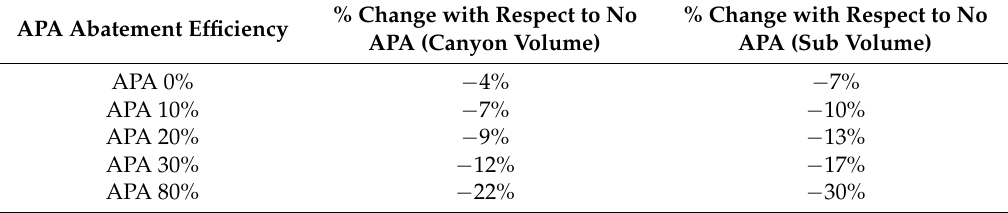
Table 2. Percent change of passive tracer average concentration in the entire volume of the canyon and in a sub-volume at human height with respect to the reference case without the scrubber for H/W = 2. Different APA abatement efficiencies are analyzed. Simulated values are relative to concentrations after 2000